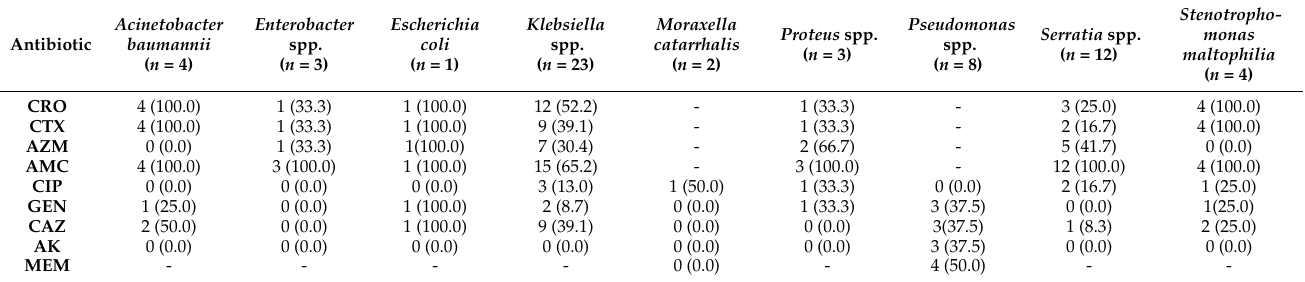
Table 5. Antimicrobial resistance patterns amongst commonly isolated pathogens in COVID-19